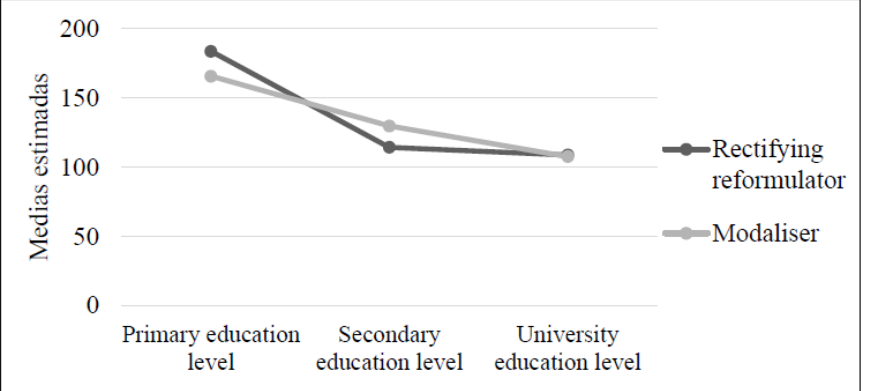
Figure 8. Use of vamos functions by educational level.